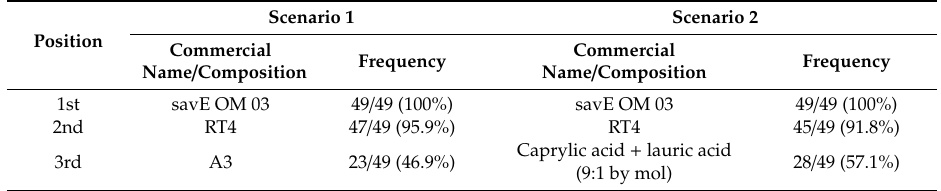
Table 7. Ranking of the best three PCM candidates and frequency distribution for the MED system. Scenario 1 Position